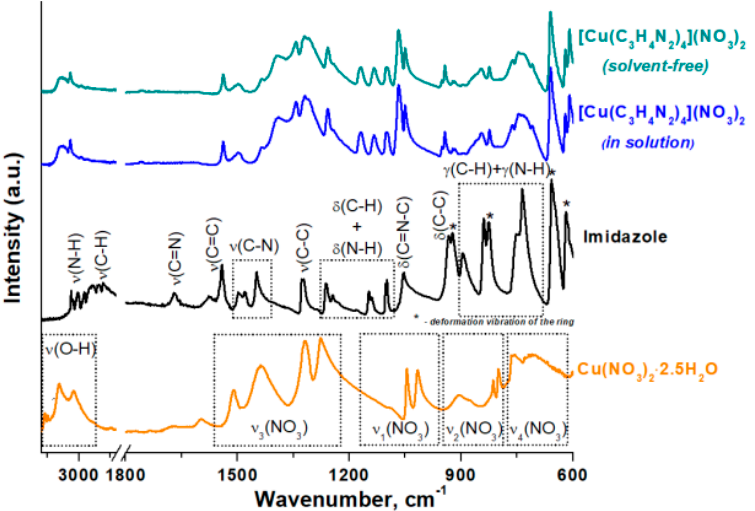
Figure 1. FTIR data for nitrate complexes of copper (II) with imidazole synthesized in the melt of copper nitrate with imidazole and in the aqueous solution.